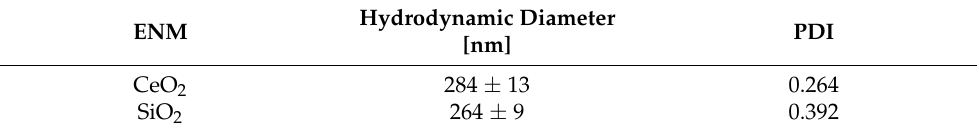
Table 2. Agglomerate diameter of CeO 2 and SiO 2 determined via DLS measurement.